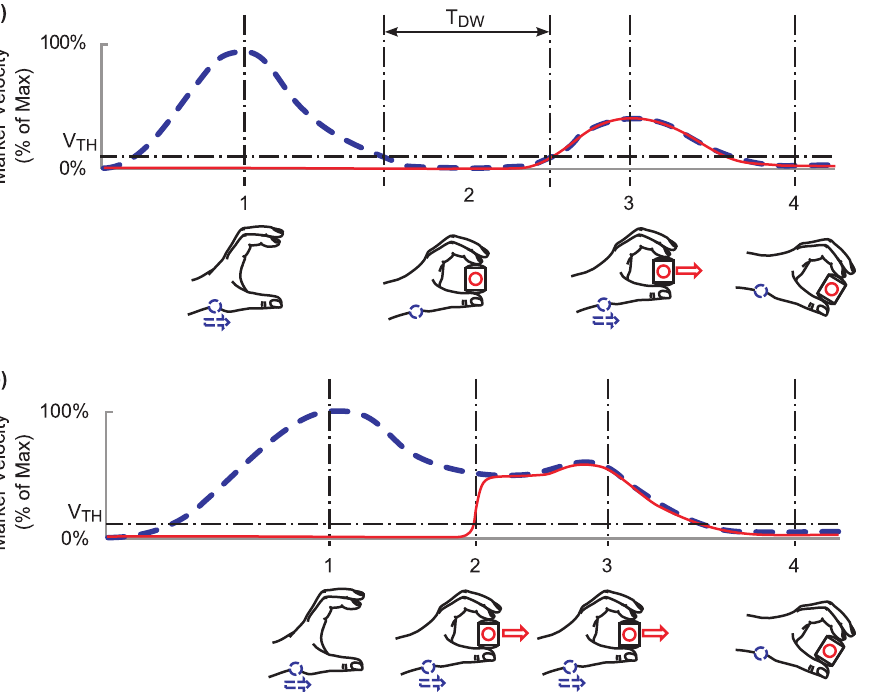
Figure 1. Kinematic profiles for stop and ‘on-the-fly’ prehension movements. Upper A velocity profile typical of a stop movement: 1, the hand is in the transport phase with the wrist IRED reaching peak velocity. 2, as the hand and fingers approach the object the hand velocity drops below the threshold velocity (V TH ) and remains below threshold velocity or stops for a period (T DW ). 3, upon successful application of the grip, both the wrist and object markers move in unison as part of a second distinct movement. 4, movement complete – hand and object velocity tends to zero. Lower A velocity profile typical of a ‘fly-through’ movement: 1, the hand is in transport phase toward the object. 2, as the fingers contact the object, the wrist IRED velocity is maintained above the threshold velocity (V TH ) as the object is gripped. 3, the hand and object continue to move in unison while the wrist IRED velocity remains above the threshold velocity. 4, movement complete, hand and object velocity tends to zero.